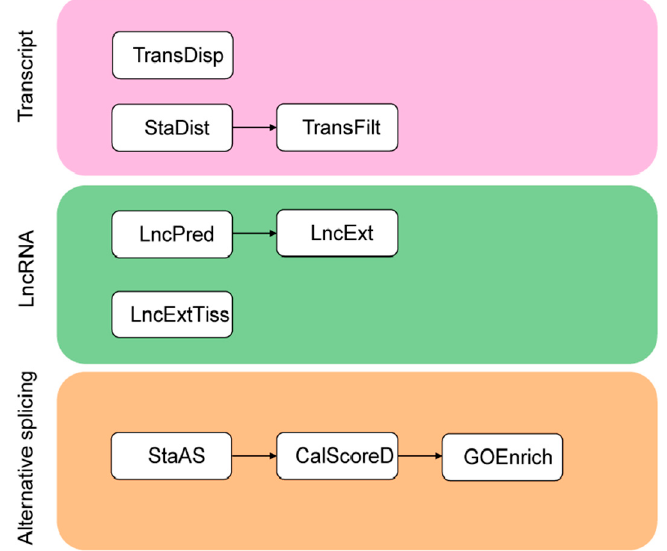
Figure 1. Overview of TGStools. A set of applications to facilitate transcriptome analysis are included in TGStools.